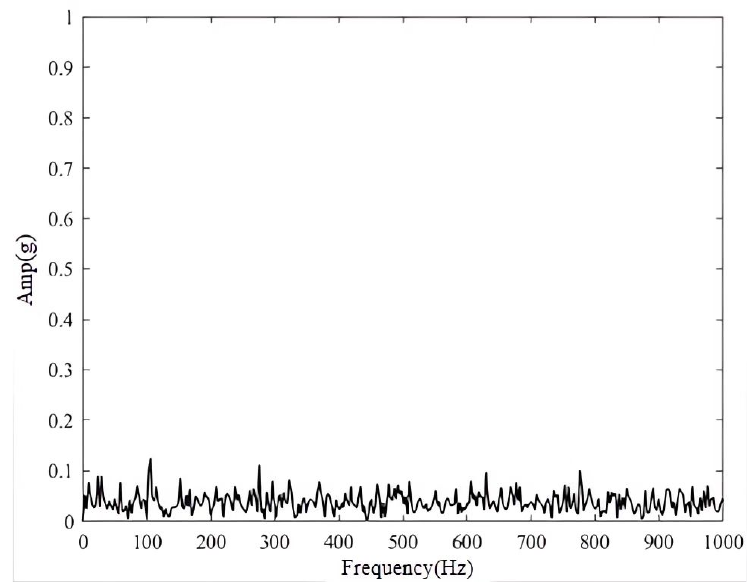
Figure 4. Outer ring fault signal envelope with strong noise added.